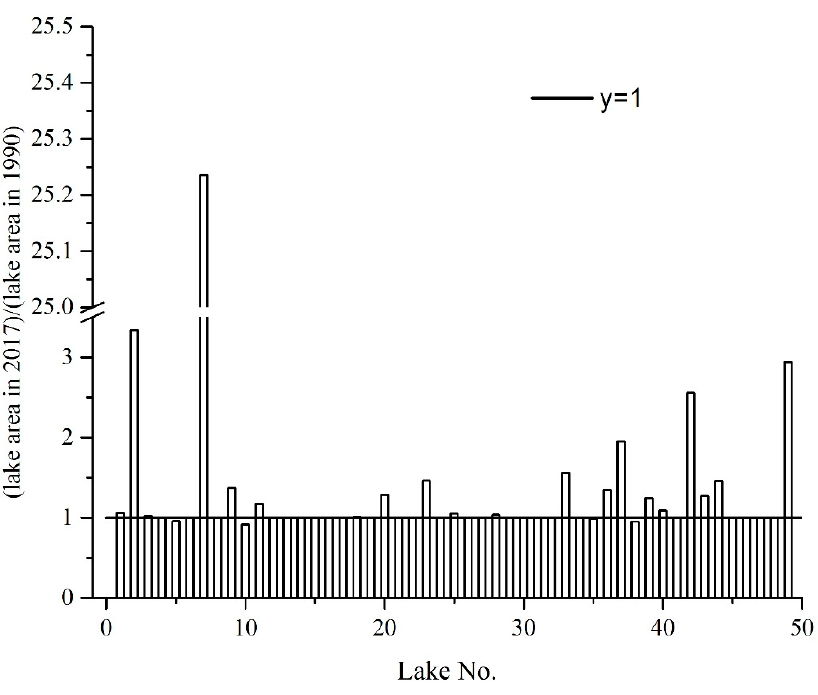
Water 2019 , 11 , x FOR PEER REVIEW Figure A1. The ratio of lake area in 2017 to that in 1990 for each lake. Figure A1. The ratio of lake area in 2017 to that in 1990 for each lake.